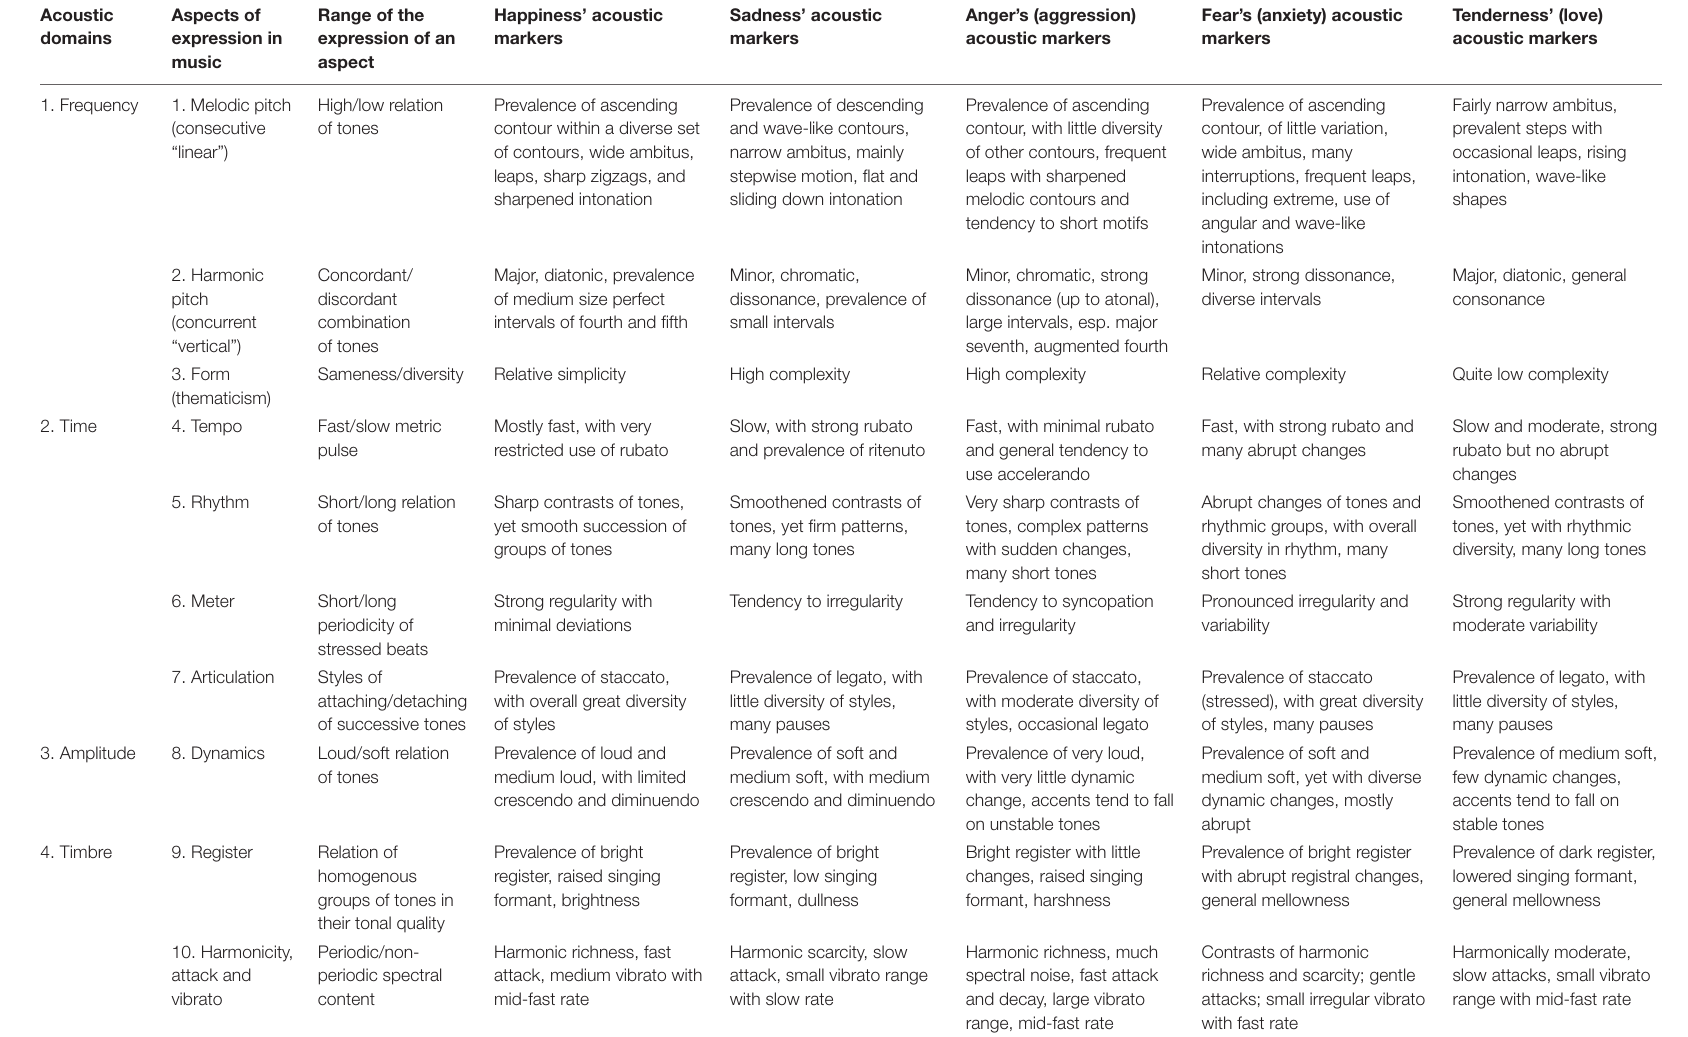
TABLE 3 | The configuration of structural patterns for each AE, typically used to express five basic